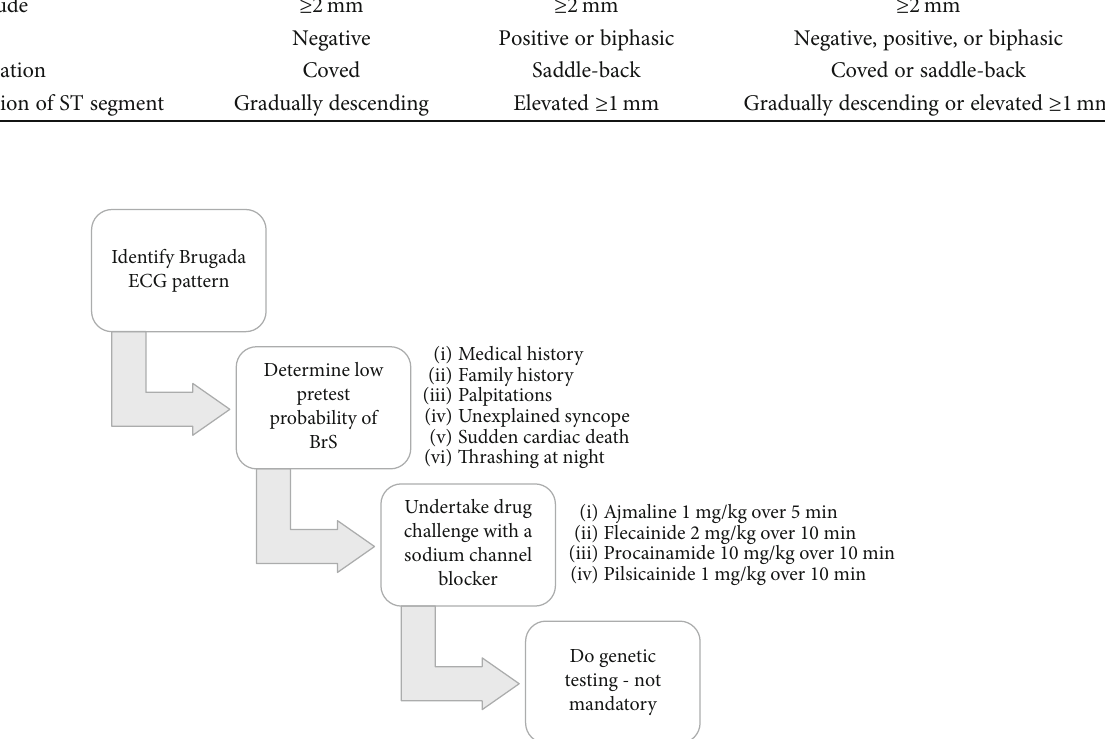
Figure 3: International Registry of Brugada Phenocopies proposed algorithm for appropriate diagnosis of Brugada